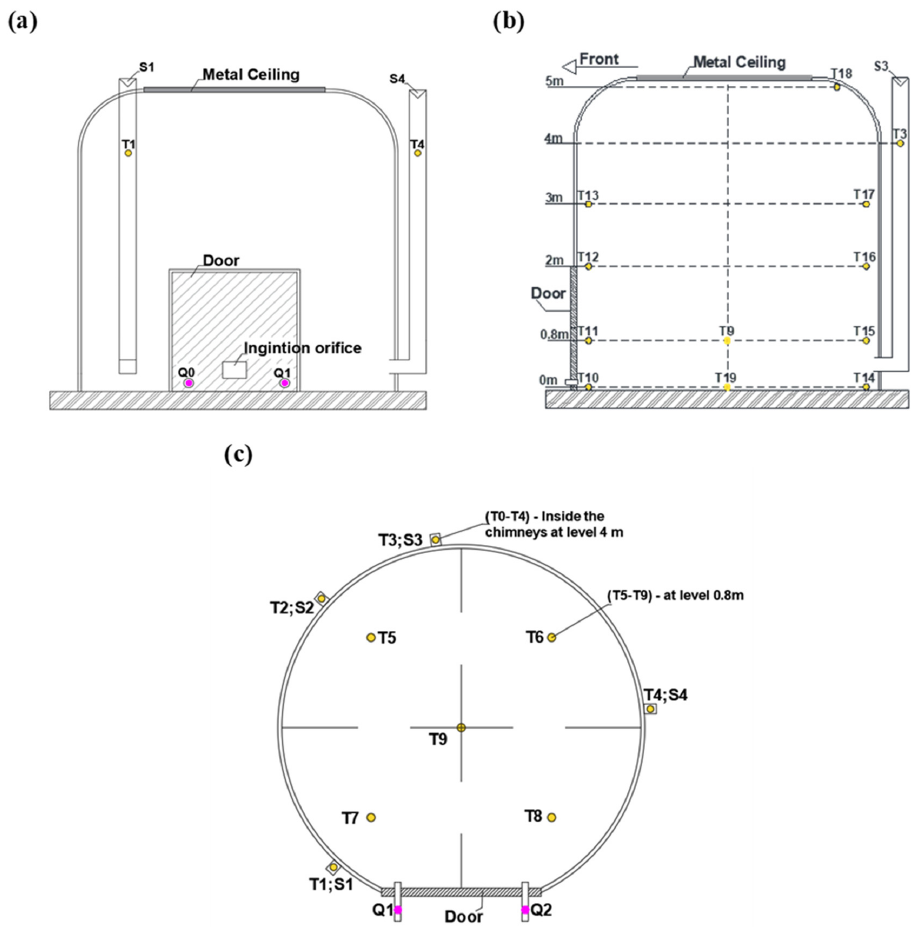
Figure 1. Schematic diagram of the kiln showing the positions of the chimneys (S1 to S4), and the temperature (T1 to T19) and airflow (Q0 and Q1) measurement ports. ( a ) front view, ( b ) side view, and ( c ) top view.